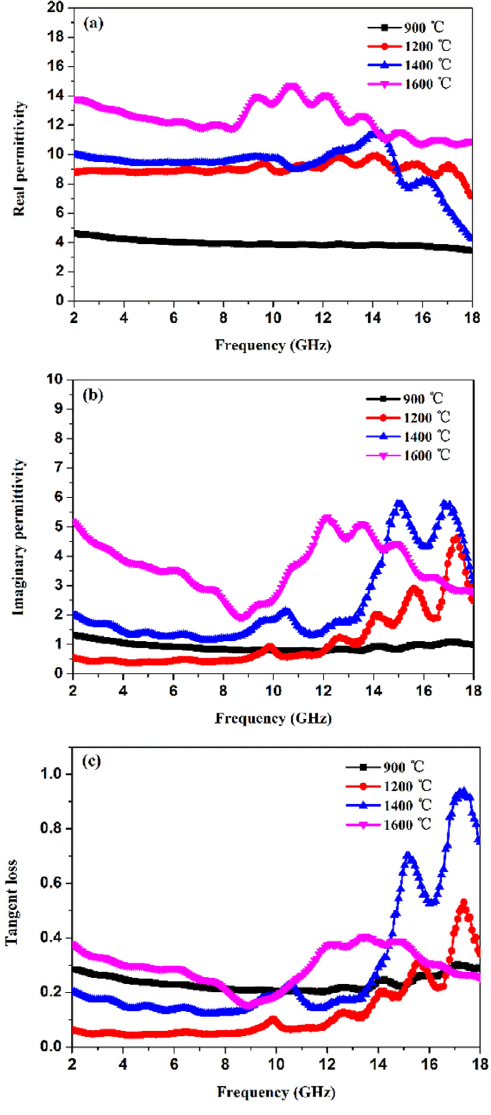
Fig. 7 (a) The real permittivity, (b) the imaginary permi- ttivity, and (c) the dielectric loss of PAD-2 derived ceramics annealed at different temperatures.